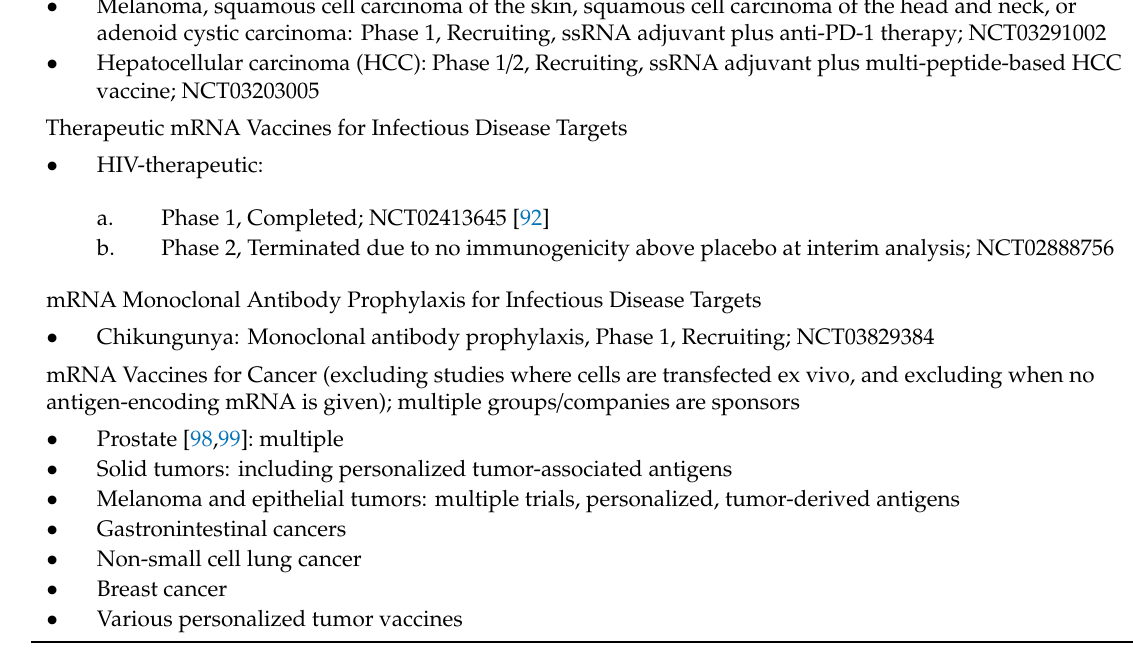
Table 4. Clinical Phase I and II trials of mRNA excluding prophylactic infectious diseases (see Table 3) and ex vivo-transduced cells. Information is taken from https: // clinicaltrials.gov. RNA-based Adjuvant: long-chain non-coding RNA complexed with a short cationic peptide (ssRNA